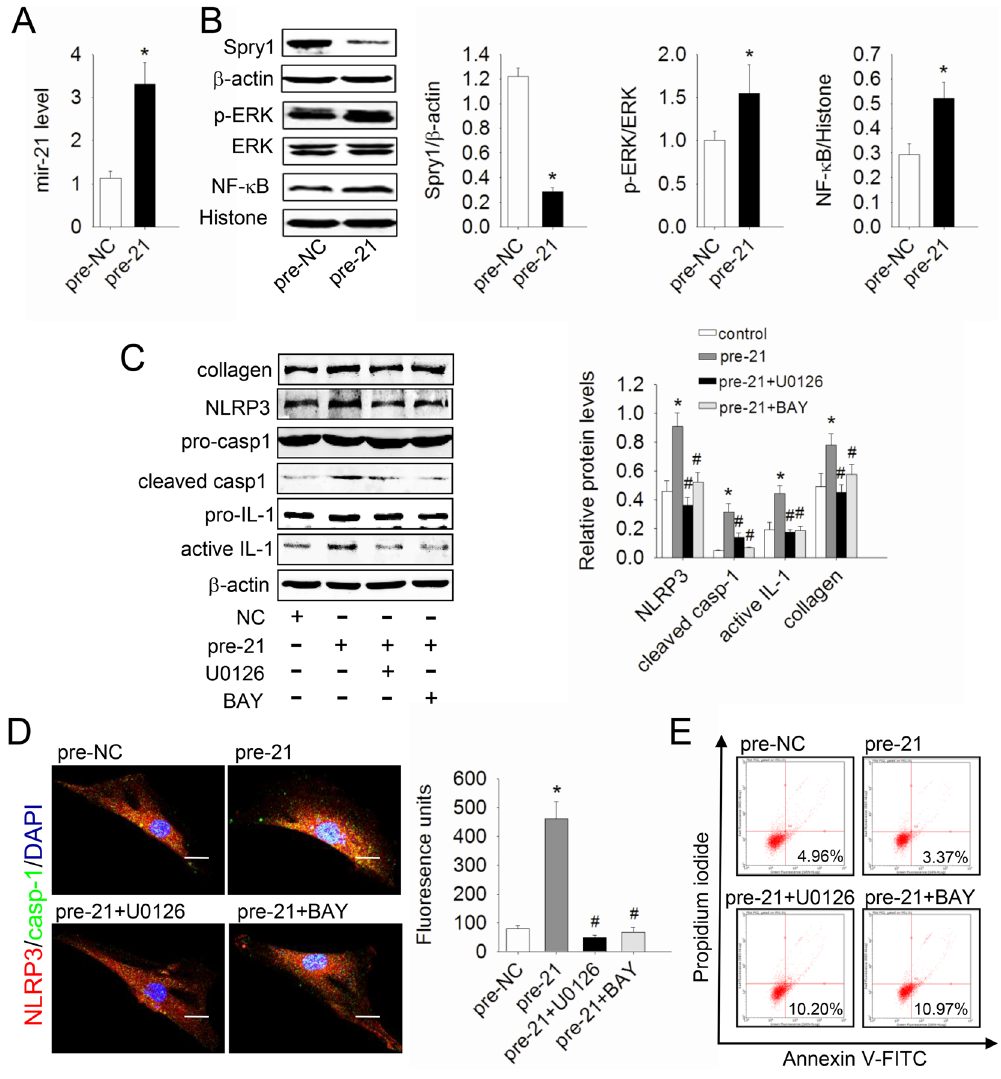
Figure 1. A correct version of the original Figure